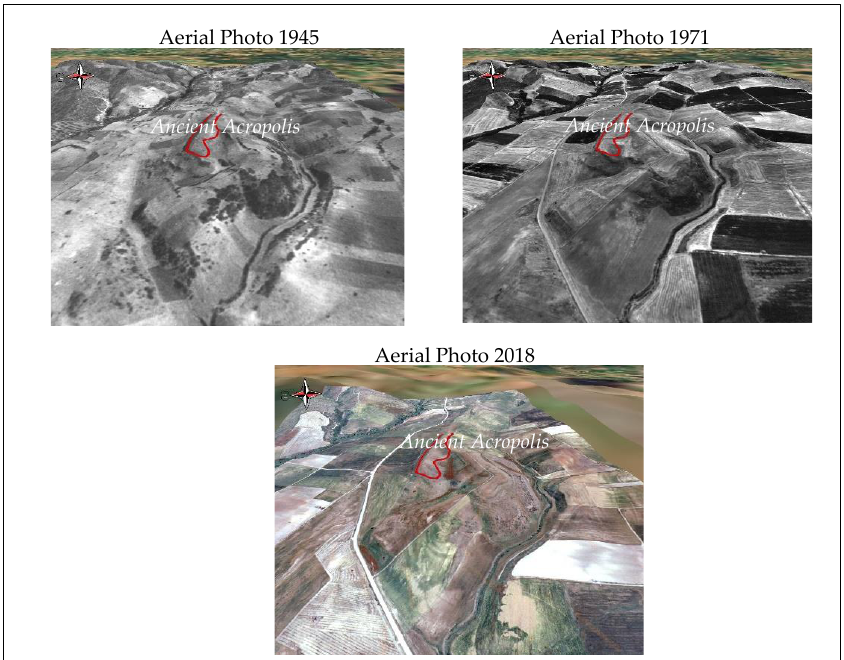
Figure 3. 3D geovisualisation of the study area in a 75-year time range.